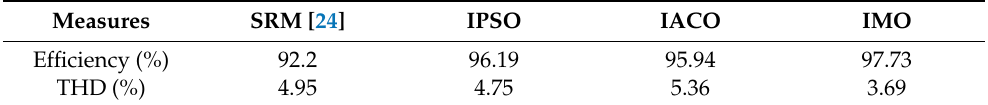
Table 3. Comparative analysis of existing